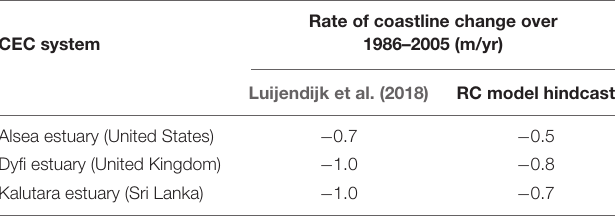
TABLE 3 | Comparison of the model hindcasted rates of coastline change over 1986–2005 with the ambient shoreline change rates presented by Luijendijk et al. (2018) over the same period.